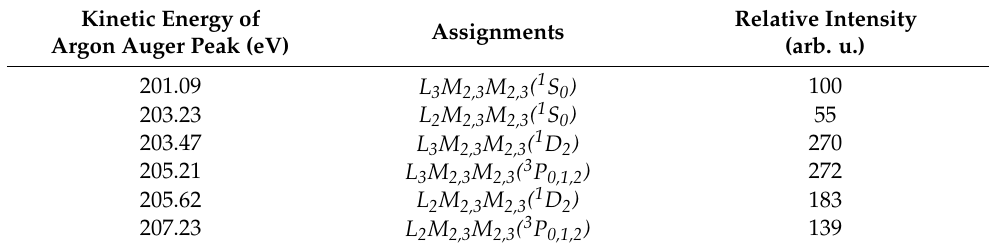
Table 1. Energies and assignment of the argon Auger lines in this experiment [24]. Kinetic Energy of